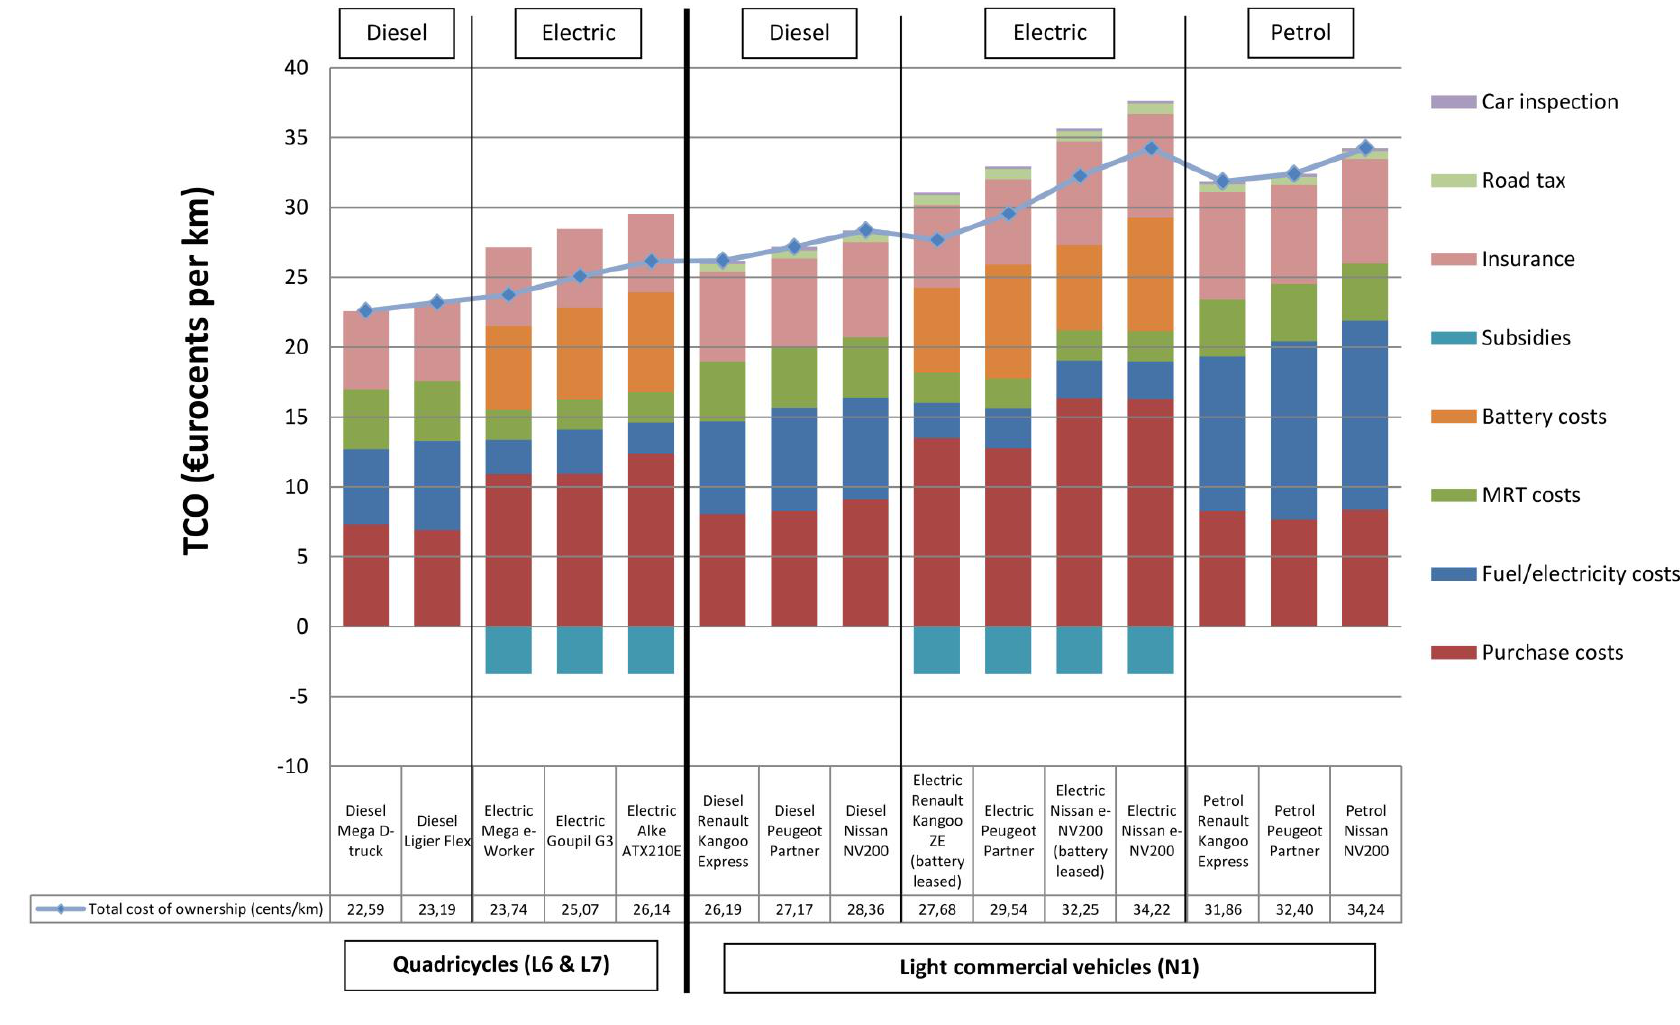
Figure 2. Total cost of ownership for diesel, petrol and battery electric